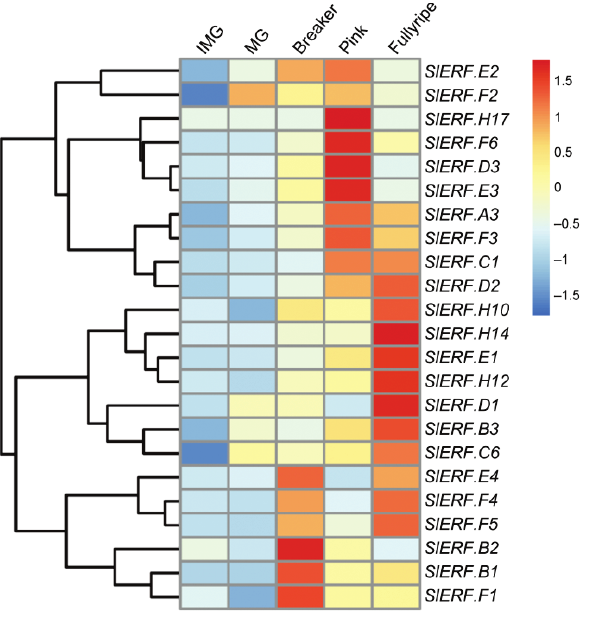
Figure 2. Gene expression pattern of ERFs in tomato fruit during ripening. Data for wildtype ( Ailsa Craig , AC) tomato fruit, downloaded from TomExpress (http://tomexpress.toulouse.inra.fr/, accessed on 15 March 2022 [46]). IMG, immature green fruit, 17 days post-anthesis (dpa); MG, mature green fruit, 39 dpa; Breaker, first sign of color change, 42 dpa; Pink, full color change, 45 dpa; Fully ripe, fruit that have reached peak ripening stage. Genes are clustered by expression patterns using pheatmap package in R 4.2.1 software. The values are displayed in color ranging from blue (low) to red (high), with genes with values below 0.5 excluded from the heatmap.